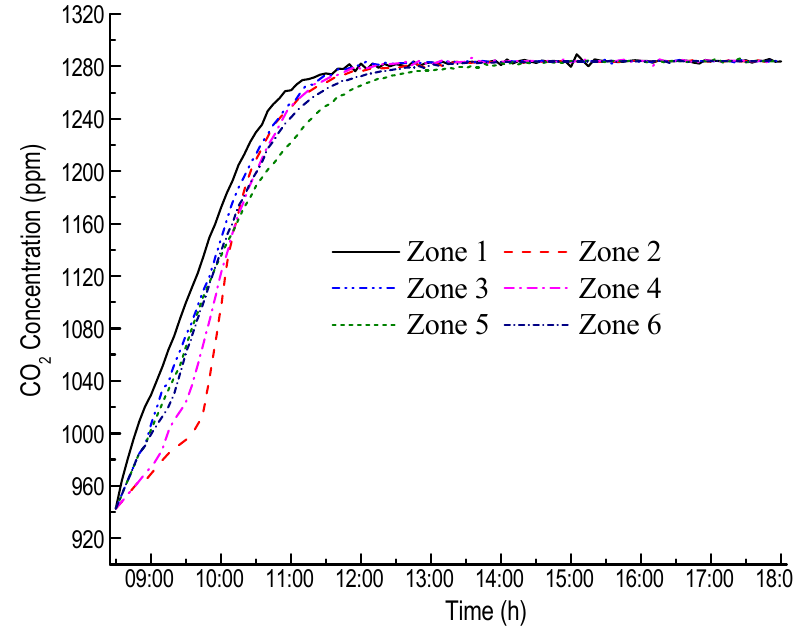
Figure 3. The CO 2 concentration levels under Scenario 1.